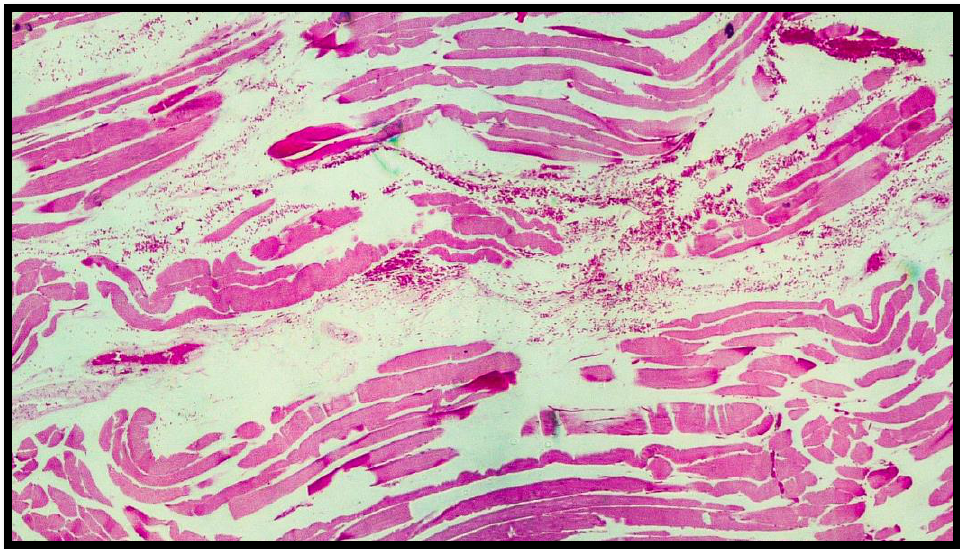
Figure 4. Histological preparation belonging to another subject showing the same characteristics mentioned in Figure 2. Note the presence of the blood red cells interspersed between the muscle fiber cells with the presence of segmentation of the muscle compartment (hematoxylin–eosin, Diapath S.p.A.). Original magnification, 4 × .